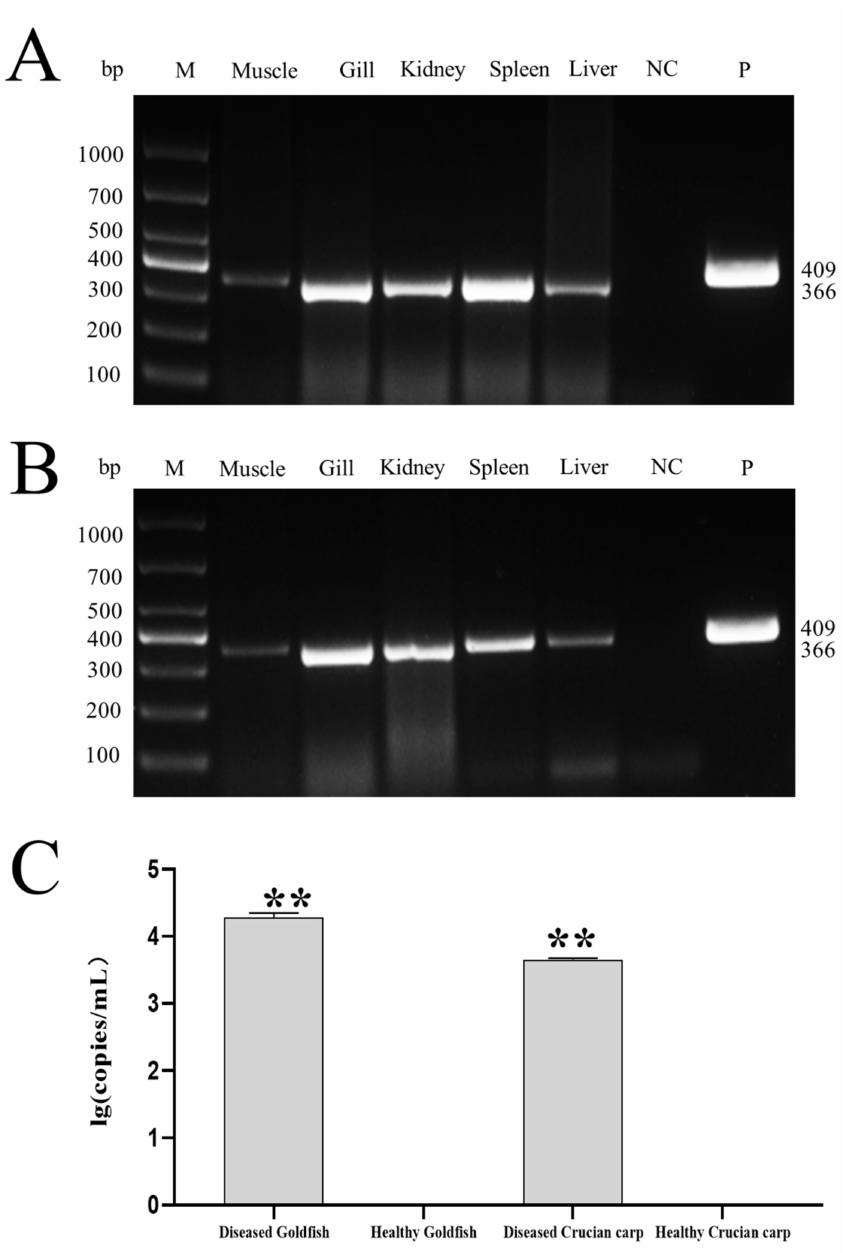
Figure 5. Virulence of CyHV-2 in goldfish and crucian carp. ( A ) CyHV-2 PCR assay of the tissue samples from the experimental goldfish. ( B ) CyHV-2 PCR assay of the tissue samples from the experimental crucian carp ( C ) CyHV-2 DNA load in kidney of experimental goldfish and crucian carp. Data are from at least three independent experiments; error bars represent the standard errors of the means (SEM). Asterisks indicate significant differences relative to the healthy goldfish or healthy crucian carp (ANOVA and Dunnett ´ s multiple comparison test; ** p <